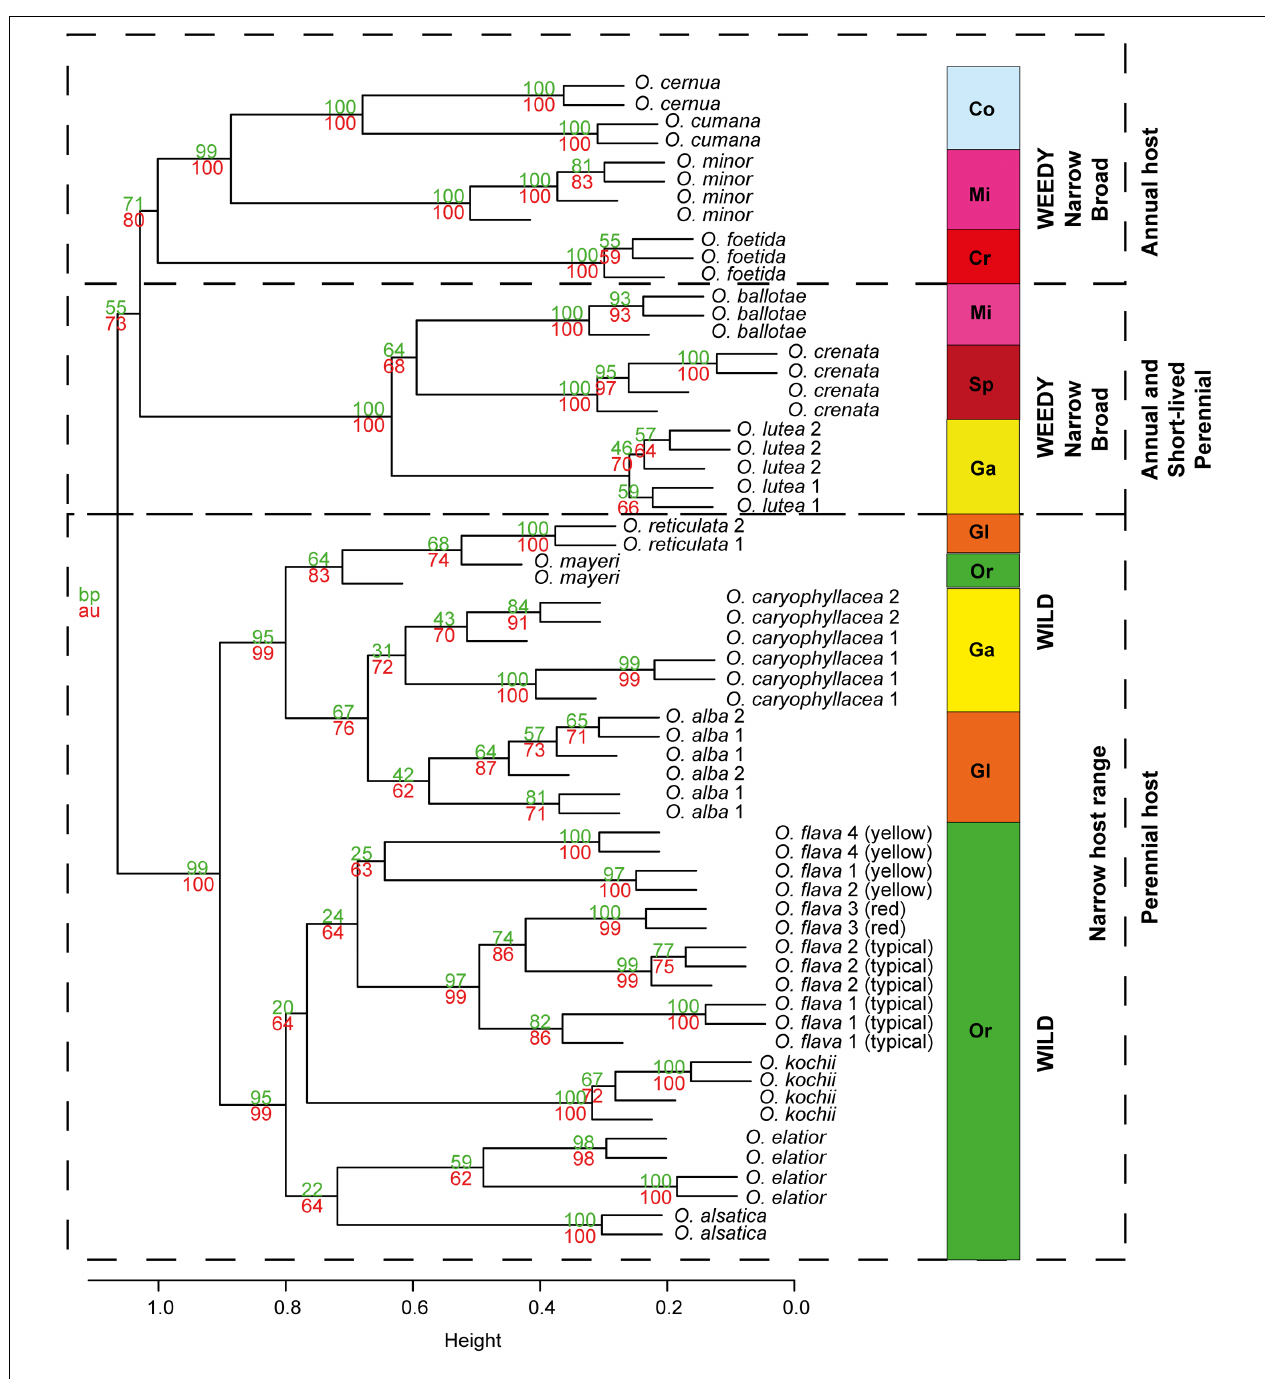
FIGURE 6 | Hierarchical clustering diagram of the flower VOC profiles of broomrapes of the genus Orobanche . HCA was performed with R and it was based on PCA using a subset with data of Orobanche spp. only. Numbers at nodes are bootstrap probability P -value (BP, upper green numbers) and approximately unbiased P -values (AU, lower red numbers). Internal taxonomic grouping of genus Orobanche as proposed by Teryokhin (1997) is shown by letters and colors which indicate subsections (sections are not specified here), CO, Coerulescentes ; CR, Cruentae ; GA, Galeatae ; GL, Glandulosae; MI, Minores; OR, Orobanche ; SP, Speciosae